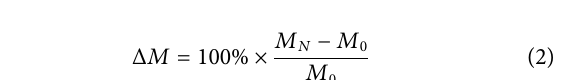
Frontiers in Materials |